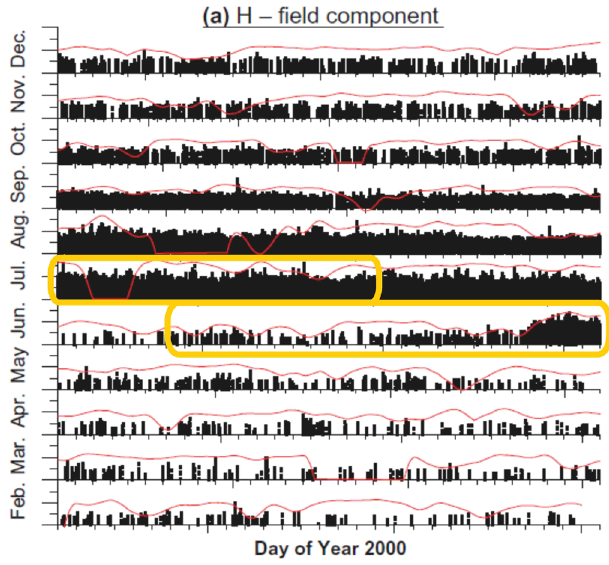
Fig. 1. A reproduction of Fig. 1 by Hayakawa et al. (2004). The ver- tical black bars represent the earthquake magnitude M ∗ estimated by the Japan Meteorological Agency, whereas the solid red line rep- resents the behaviour of the Hurst exponent of the geomagnetic field H component during 2000. Yellow rounded rectangles highlight the period in which the Hurst exponent is claimed to change coherently with M ∗ by Hayakawa et al.